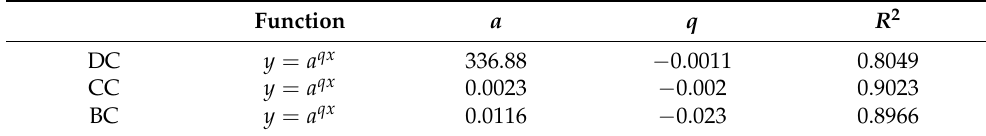
Table 2. Best-fitting models for indices ( y ) and ranks ( x ).